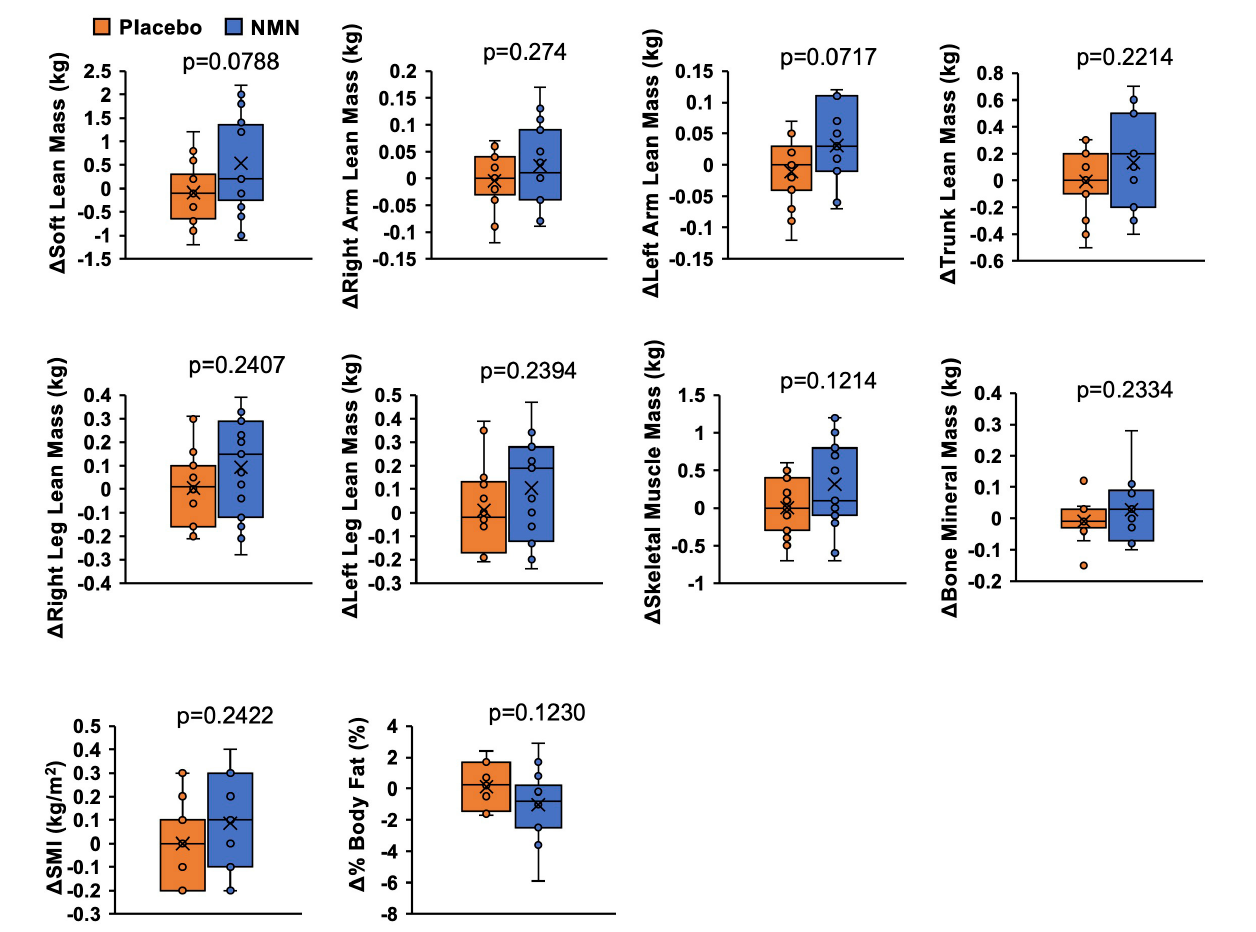
FIGURE 4 | Amount of change of body composition implied increased muscle mass and reduced body fat. Body composition was measured with InBody770 at 0- and 12-week. Value at 0-week was subtracted from value at 12-week to calculate amount of change. Orange represents placebo group ( n = 14) and blue represents NMN group ( n = 15). Data are represented as mean ± SD. SMI, skeletal muscle mass